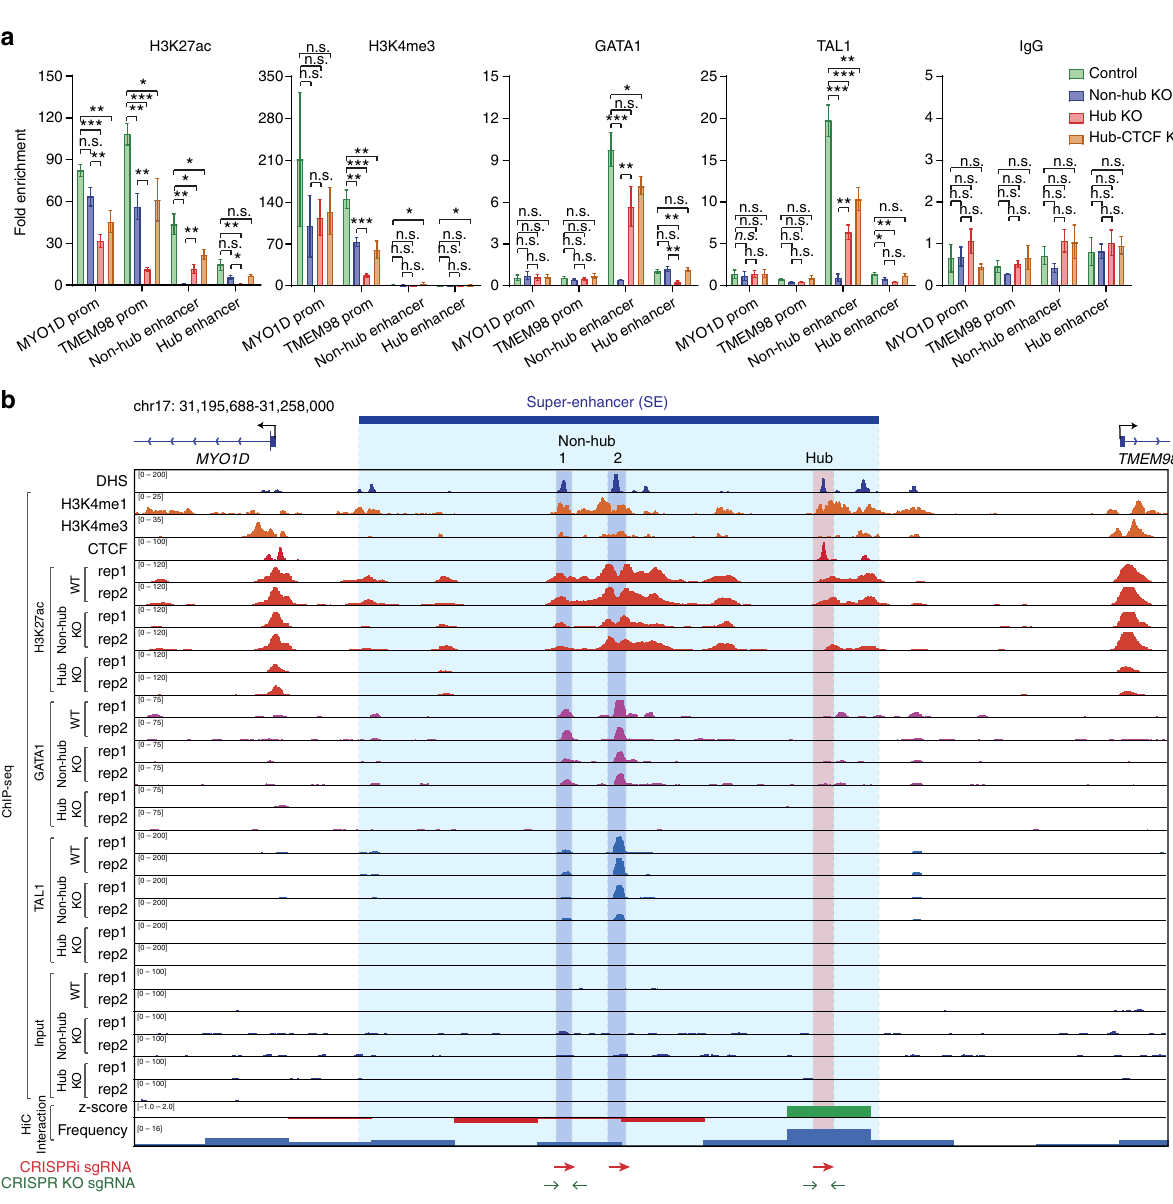
Fig. 6 Effect on chromatin landscape and TF binding upon KO of the MYO1D hub enhancer. a ChIP-qPCR analysis of H3K27ac, H3K4me3, GATA1, TAL1 and IgG (negative control) in unmodi fi ed (control), hub, non-hub enhancer or the CTCF binding site within the hub enhancer knockout cells. Primers against MYO1D and TMEM98 promoters, hub and non-hub enhancers, and a negative control genome region (chr2:211,337,339 – 211,337,429) are used. The results are shown as fold enrichment of the ChIP signals against the negative control region as means ± s.e.m. of four independent experiments. It is important to note that the low or lack of ChIP signals at the non-hub or hub enhancer regions is due to the deletion of the non-hub or hub enhancers containing the primer binding sites. P values were calculated by a two-sided Student ’ s t-test. * P < 0.05, ** P < 0.01, *** P < 0.001, n.s. not signi fi cant. b ChIP- seq analysis of H3K27ac, GATA1 and TAL1 in control (WT), hub or non-hub enhancer knockout K562 cells. Browser view of the ChIP-seq intensity from two independent ChIP-seq experiments (rep1 and rep2) is shown. The identi fi ed hub and non-hub enhancers are depicted by red (hub) and blue (non-hub) lines, respectively. The Hi-C chromatin interaction z -score and frequency at 5 kb resolution is shown at the bottom (see Methods). The positions of sgRNAs used for CRISPRi or CRISPR-Cas9-mediated knockout analyses are shown as